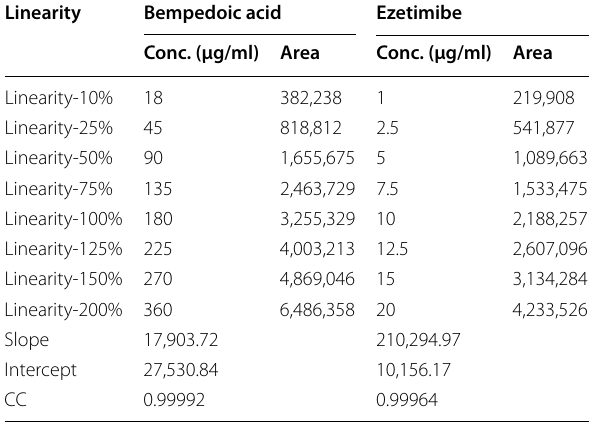
Table 2 UPLC results of